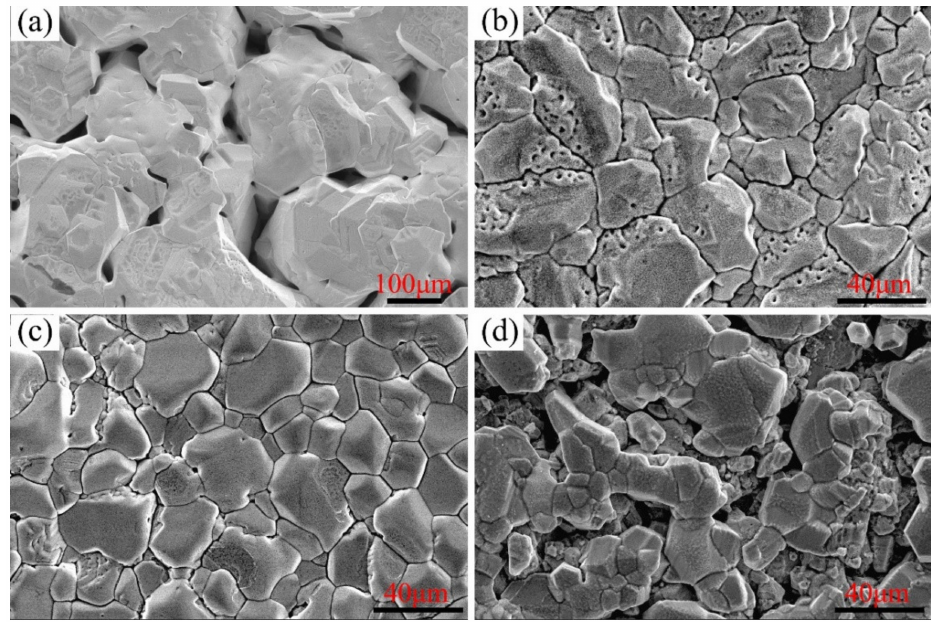
Figure 8. Secondary electron morphology of Ni–xCr–Mo laser-cladding coatings corroded for 168 h at 600 ◦ C: ( a ) C1, ( b ) C2, ( c ) C3, and ( d )